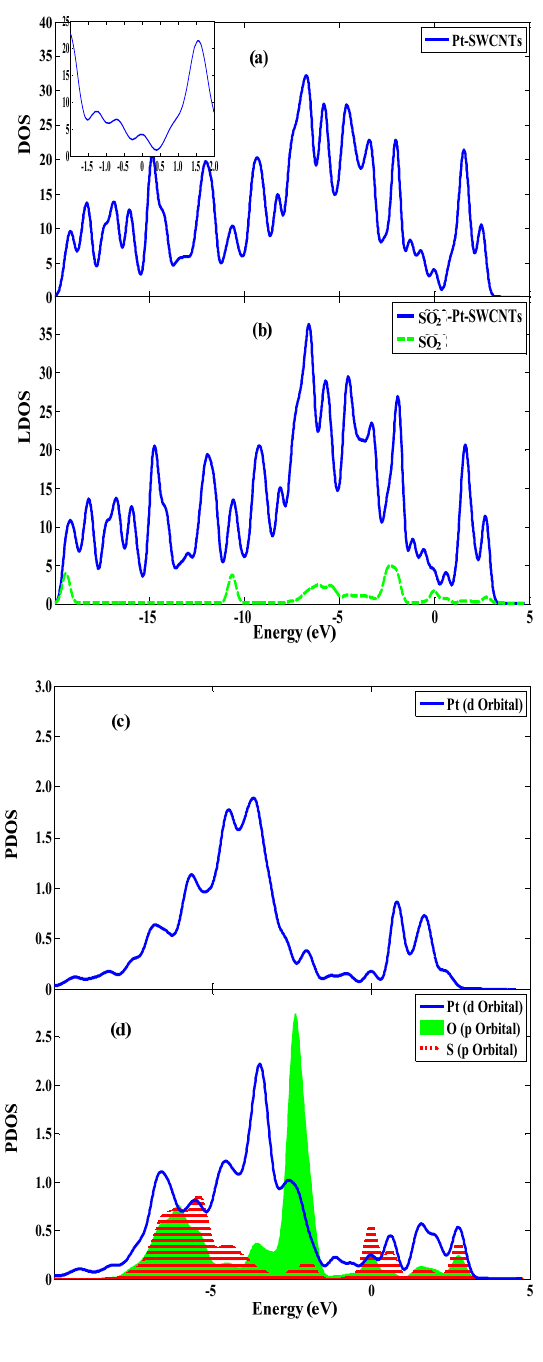
Figure 3. The density of states of Pt-SWCNTs before and after SO DOS of Pt-SWCNTs; ( b ) The LDOS of SO ( c ) The PDOS of Pt in Pt-SWCNTs; ( d ) The PDOS of Pt, O and S in SO (Fermi level is